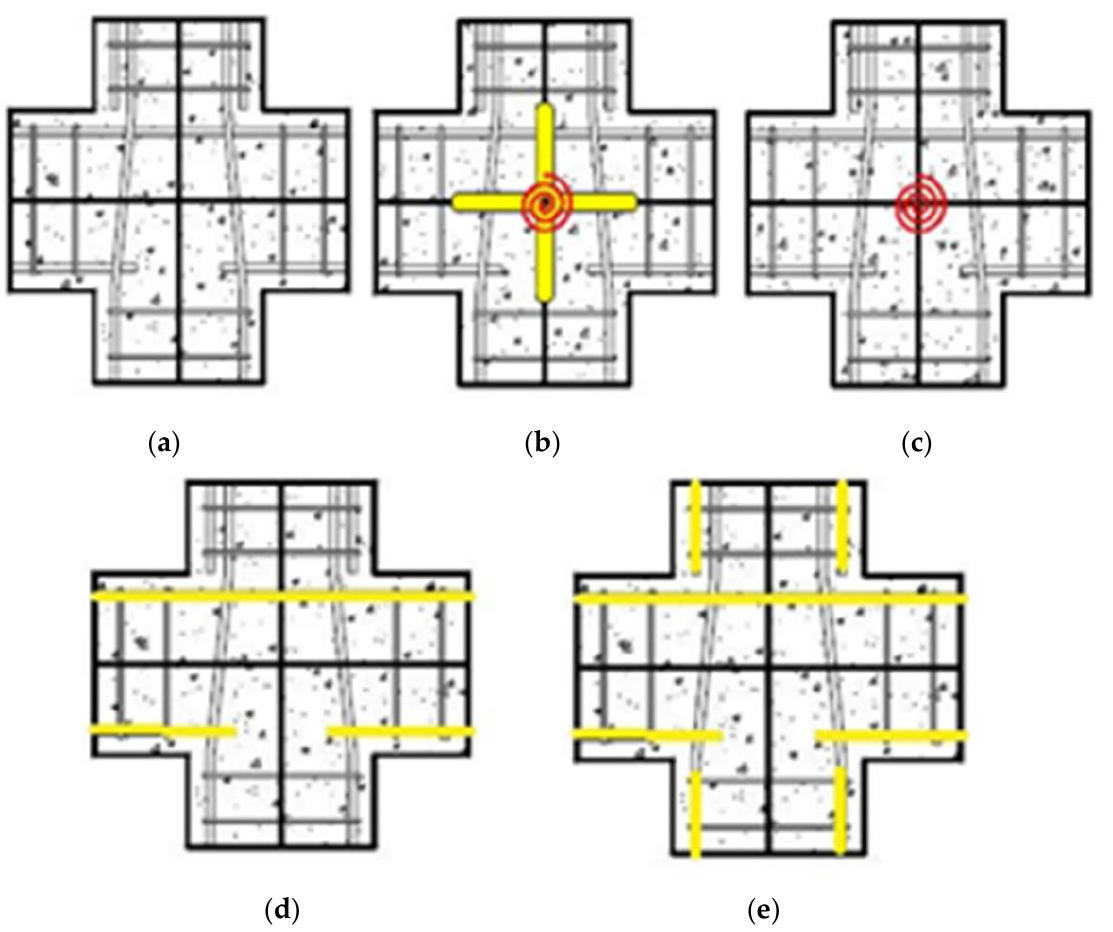
Figure 3. ( a ) Joint centerline model, ( b , c ) scissors model with and without rigid links, ( d ) centerline model with decreased beam-bending capacity, and ( e ) centerline model with decreased bending capacities of both beams and columns, reproduced from literature [21].